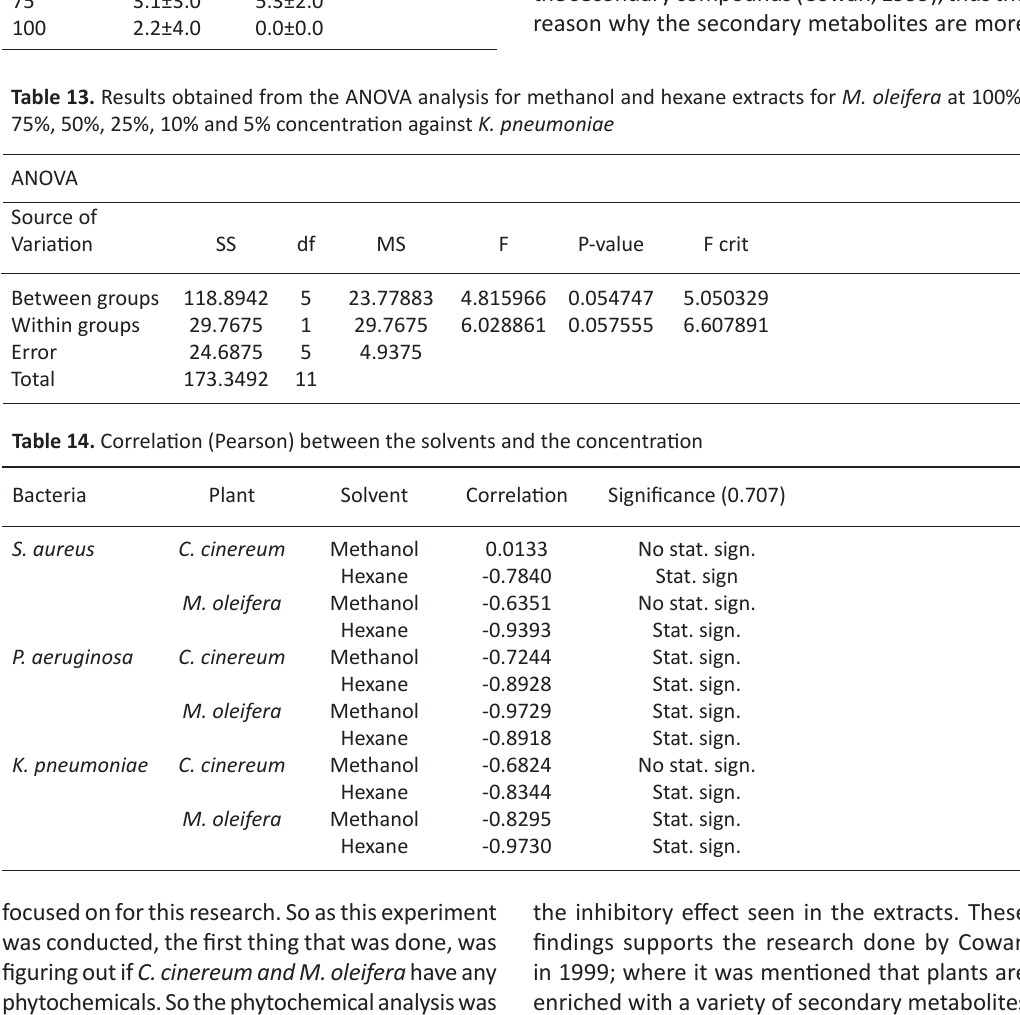
Table 12. Mean and Standard deviation for methanol and hexane extracts for M. oleifera at 100%, 75%, 50%, 25%, 10% and 5% concentration against K. pneumoniae Concen. % zone of inhibition (mm)